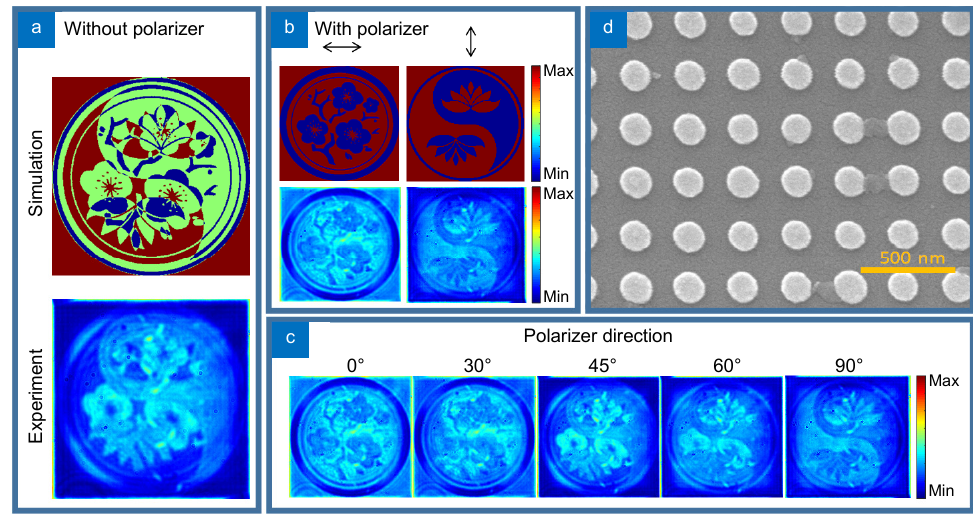
Fig. 5 | Experimental results of polarization detection . ( a ) The simulated and experimental results of images without polarizer, the intensity profile is the superposition of two images. ( b ) The simulated and experimental results of images with polarizer along the horizontal and vertical directions, respectively. ( c ) Experimental results at 0°, 30°, 45°, 60° and 90° by gradually rotating the analyzer, the pattern gradually transformed from plum blossom to lotus. ( d ) SEM image of the fabricated metasurface. The scale bar is 500